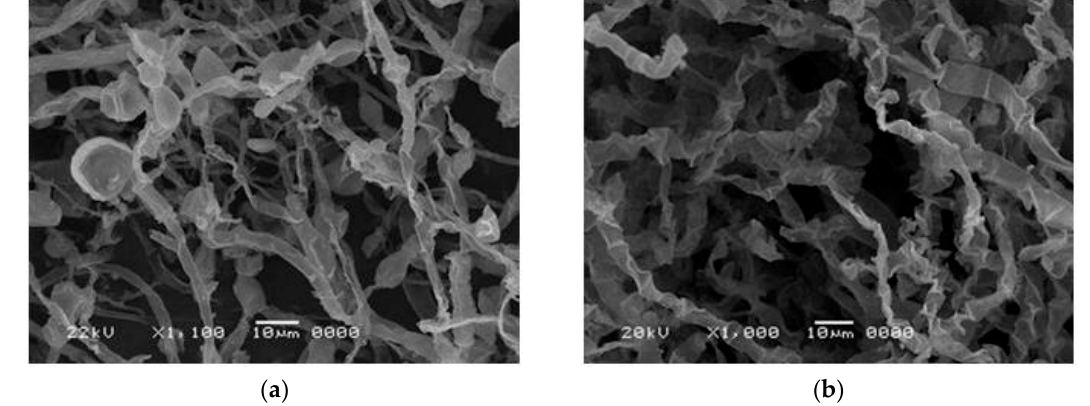
Figure 3. Scanning electron micrograph of mycelium of Mucor subtilissimus (UCP 1262) and Lichtheimia hyalospora (UCP 1266). ( a ) M. subtilissimus (UCP 1262) after cultivation in assay 2 of the factorial design (CSL 6% and CWW 4%) and ( b ) L. hyalospora (UCP 1266) after cultivation in assay central point of the factorial design (CSL 4% and 6% CWW).